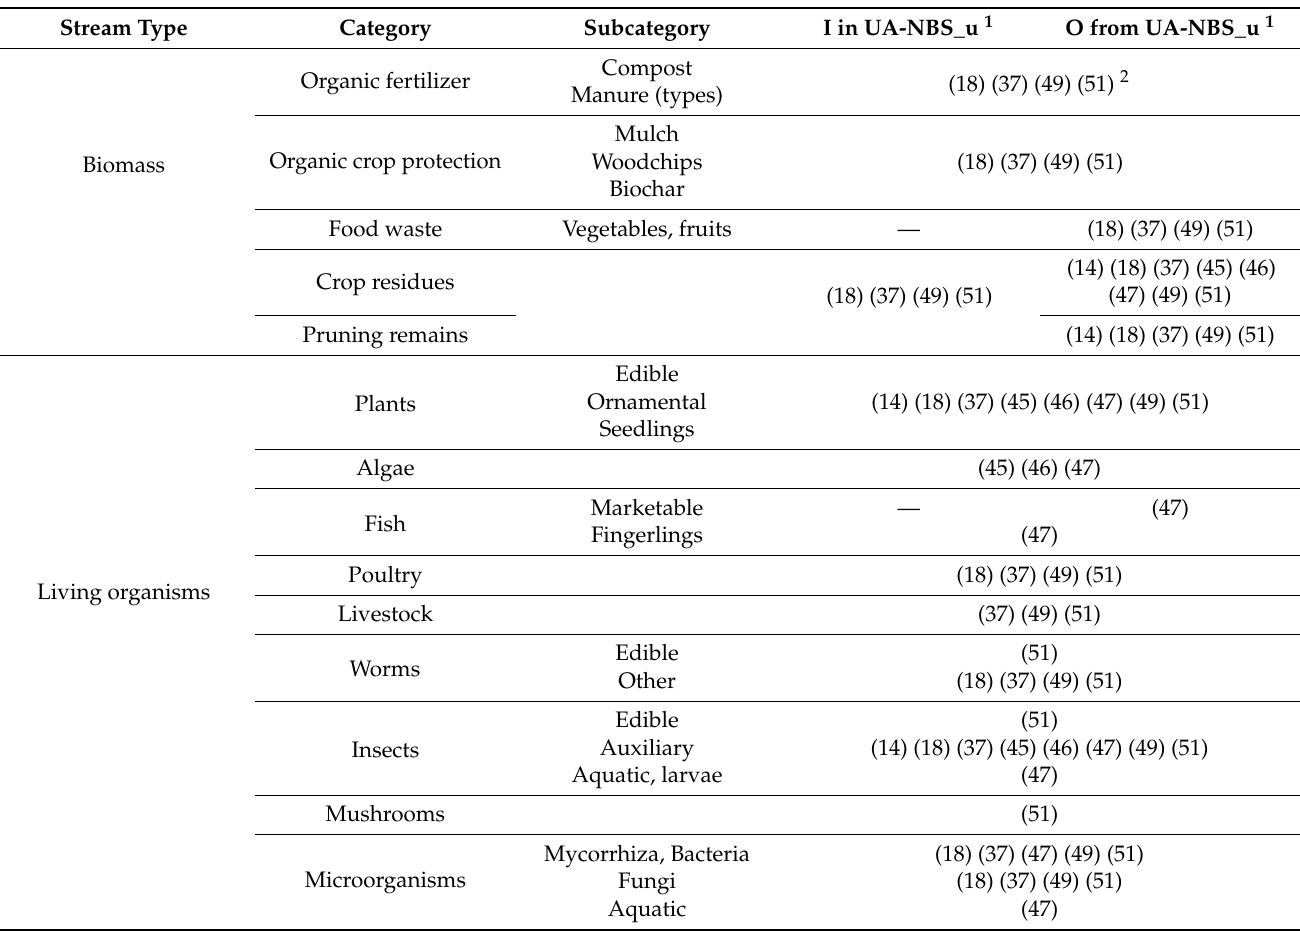
Table 3. Biomass and living organisms as resource streams related to nature-based solutions units (NBS_u) associated with urban agriculture while address the fifth urban circularity challenge on “Food and biomass production”